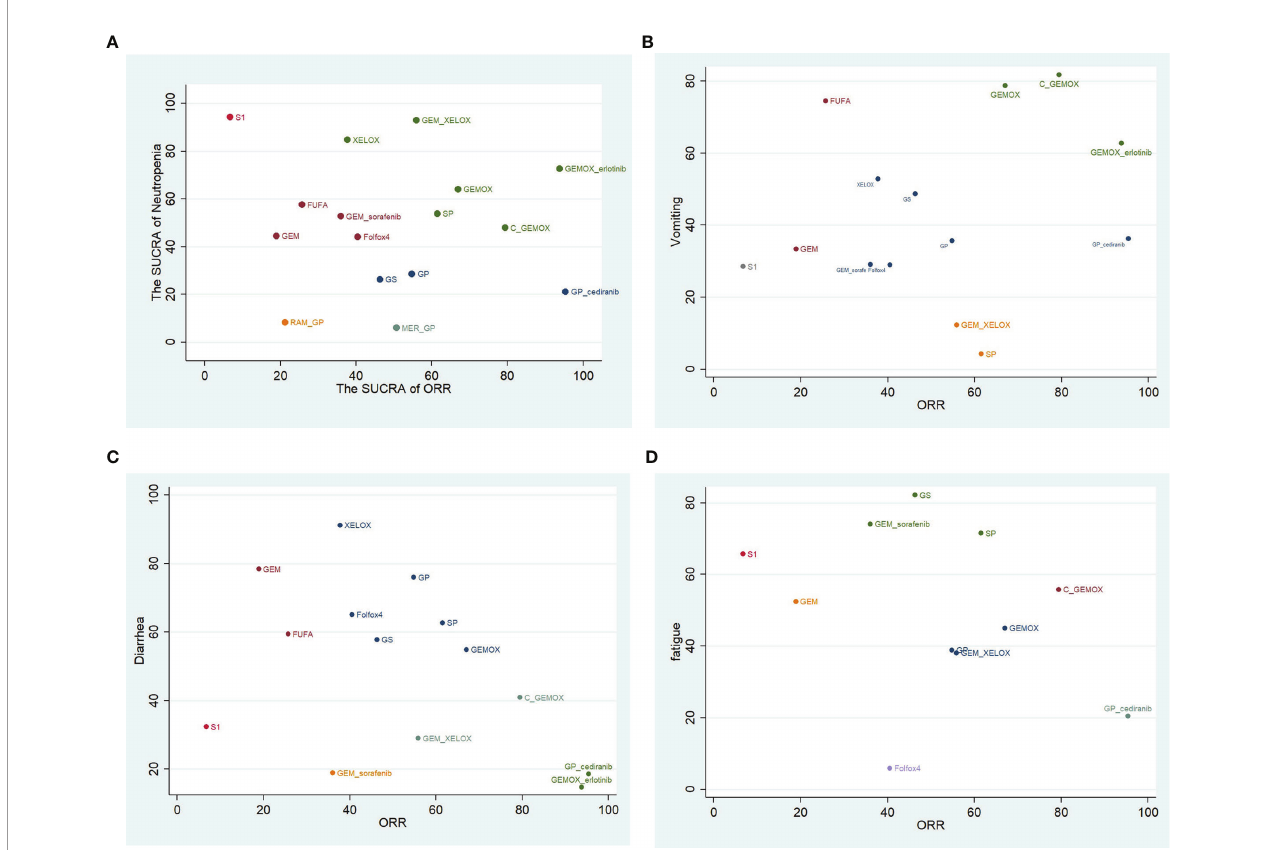
FIGURE 9 | Clustered ranking plot on objective remission rate (ORR) and adverse events (AEs) both expressed as surface under the cumulative rankings (SUCRAs): (A) neutropenia; (B) vomiting; (C) diarrhea; (D)